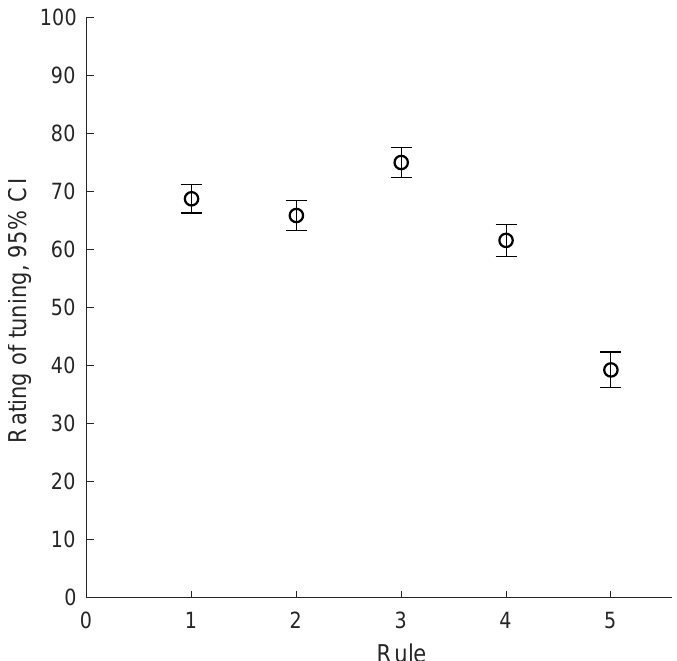
Figure 2. Average results of the listening test and the 95% confidence intervals. The rules tested were (1) professional tuning, (2) geometric mean rule (GM), (3) matching first partial (m1), (4)